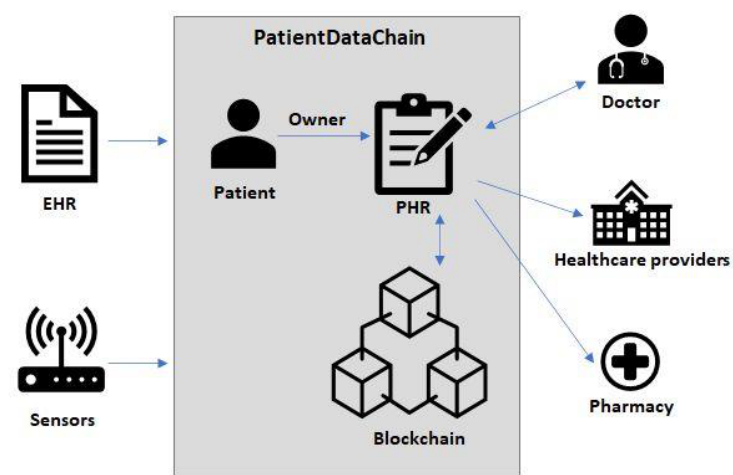
Figure 1. PatientDataChain architectural overview.